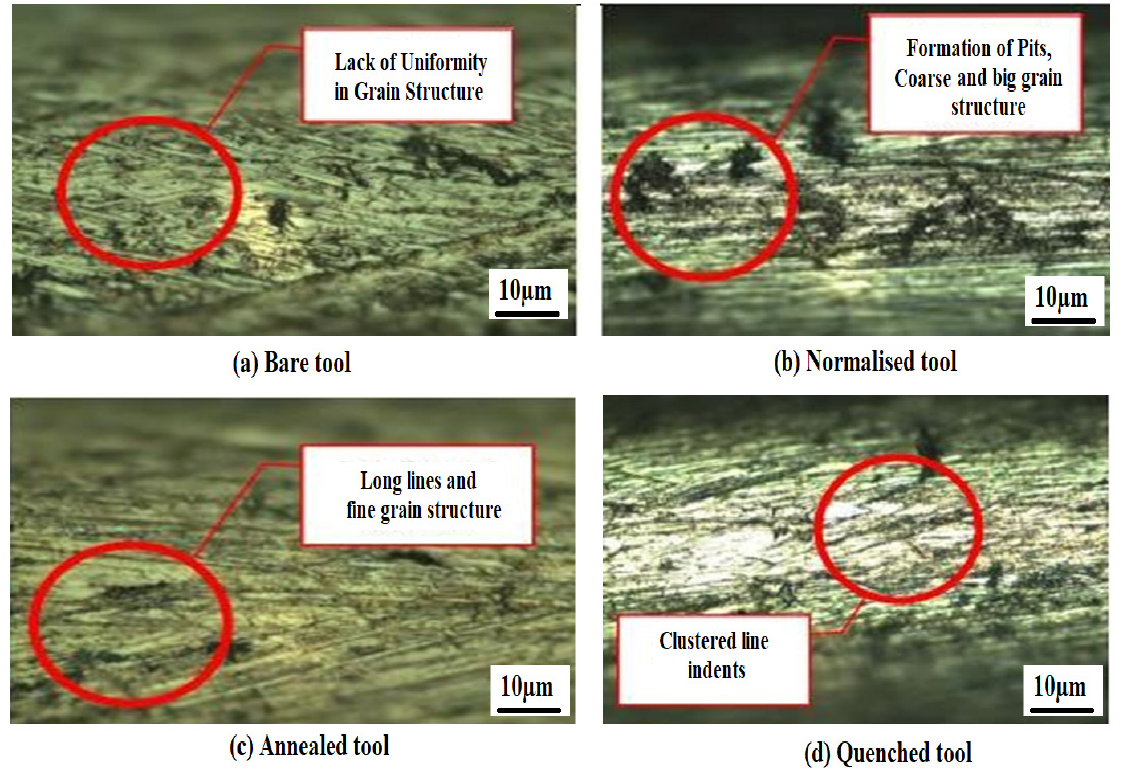
Figure 2. Steps’ effect of heat treatment on tool electrode. ( a ) Bare tool; ( b ) Normalized tool; ( c ) Annealed tool; ( d ) Quenched tool.